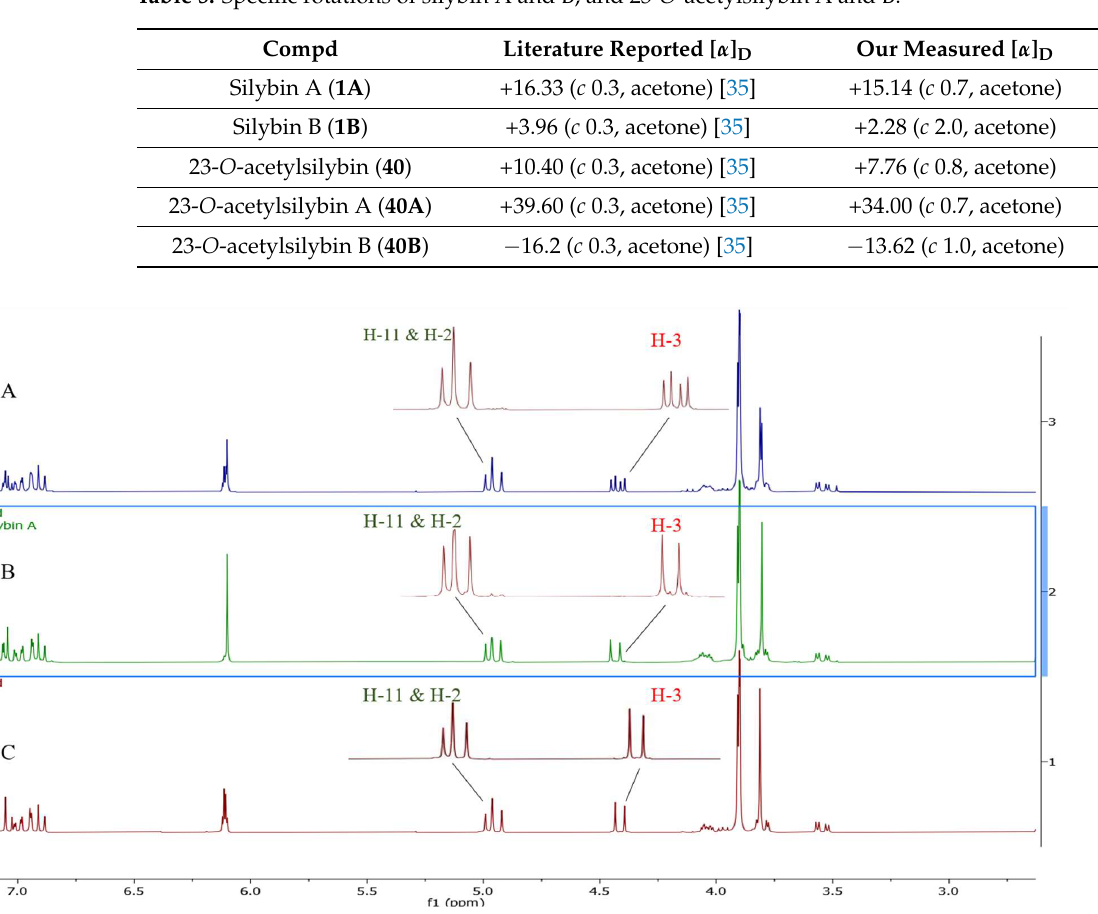
Table 5. Specific rotations of silybin A and B, and 23- O -acetylsilybin A and B.